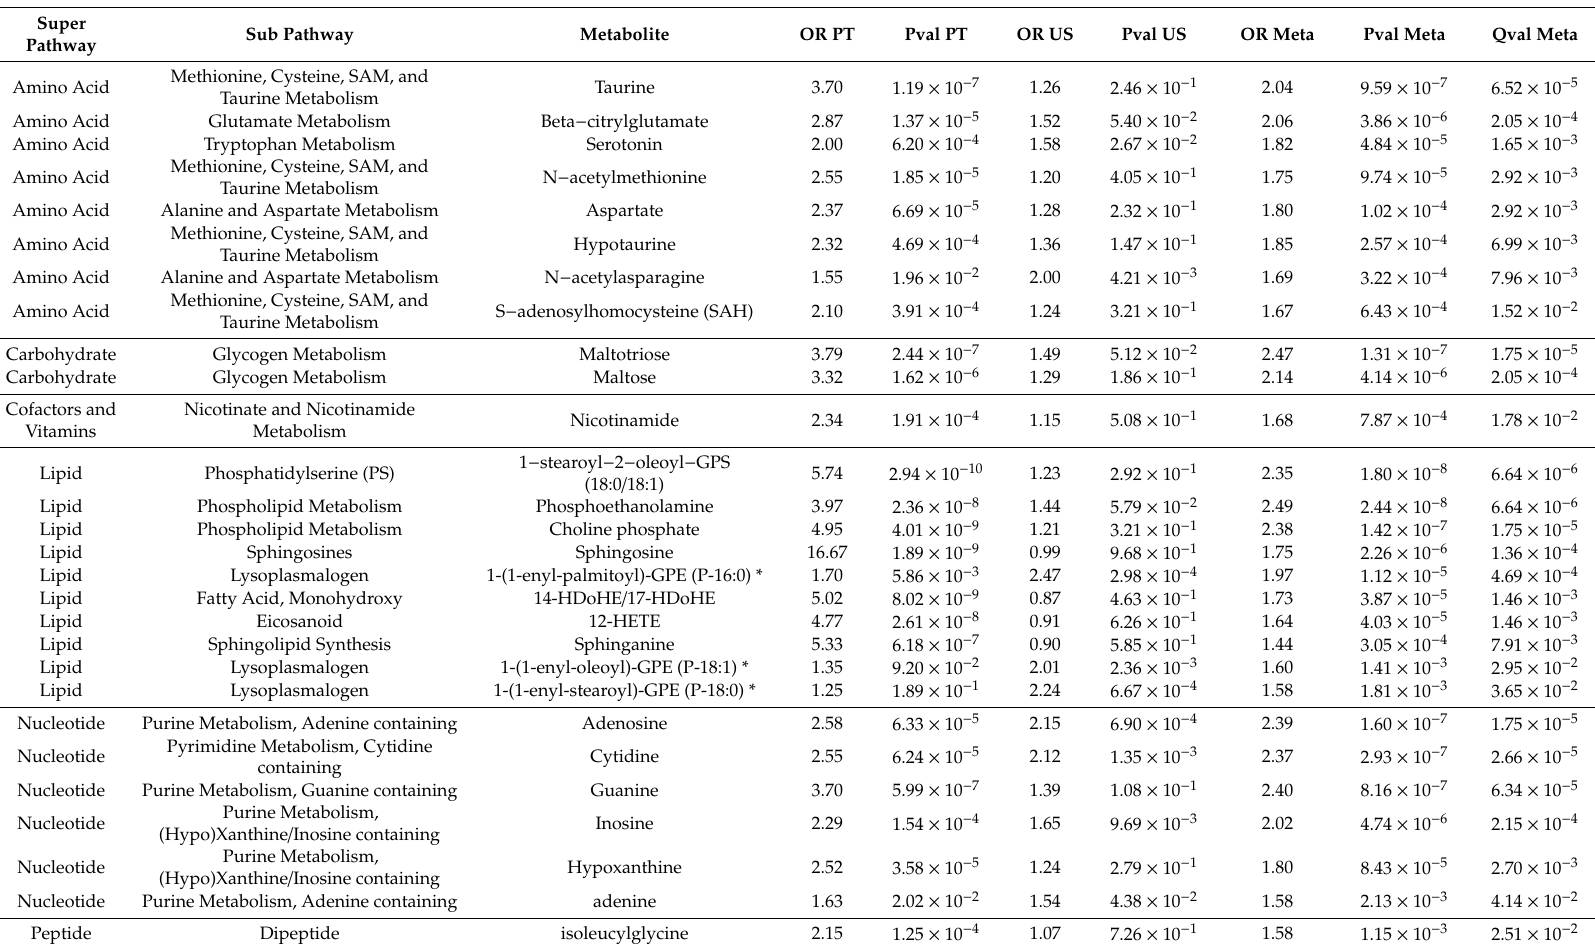
Table 2. Metabolites di ff ering significantly ( q -value) between patients with AMD and controls, based on meta-analysis of the two study cohorts. Super